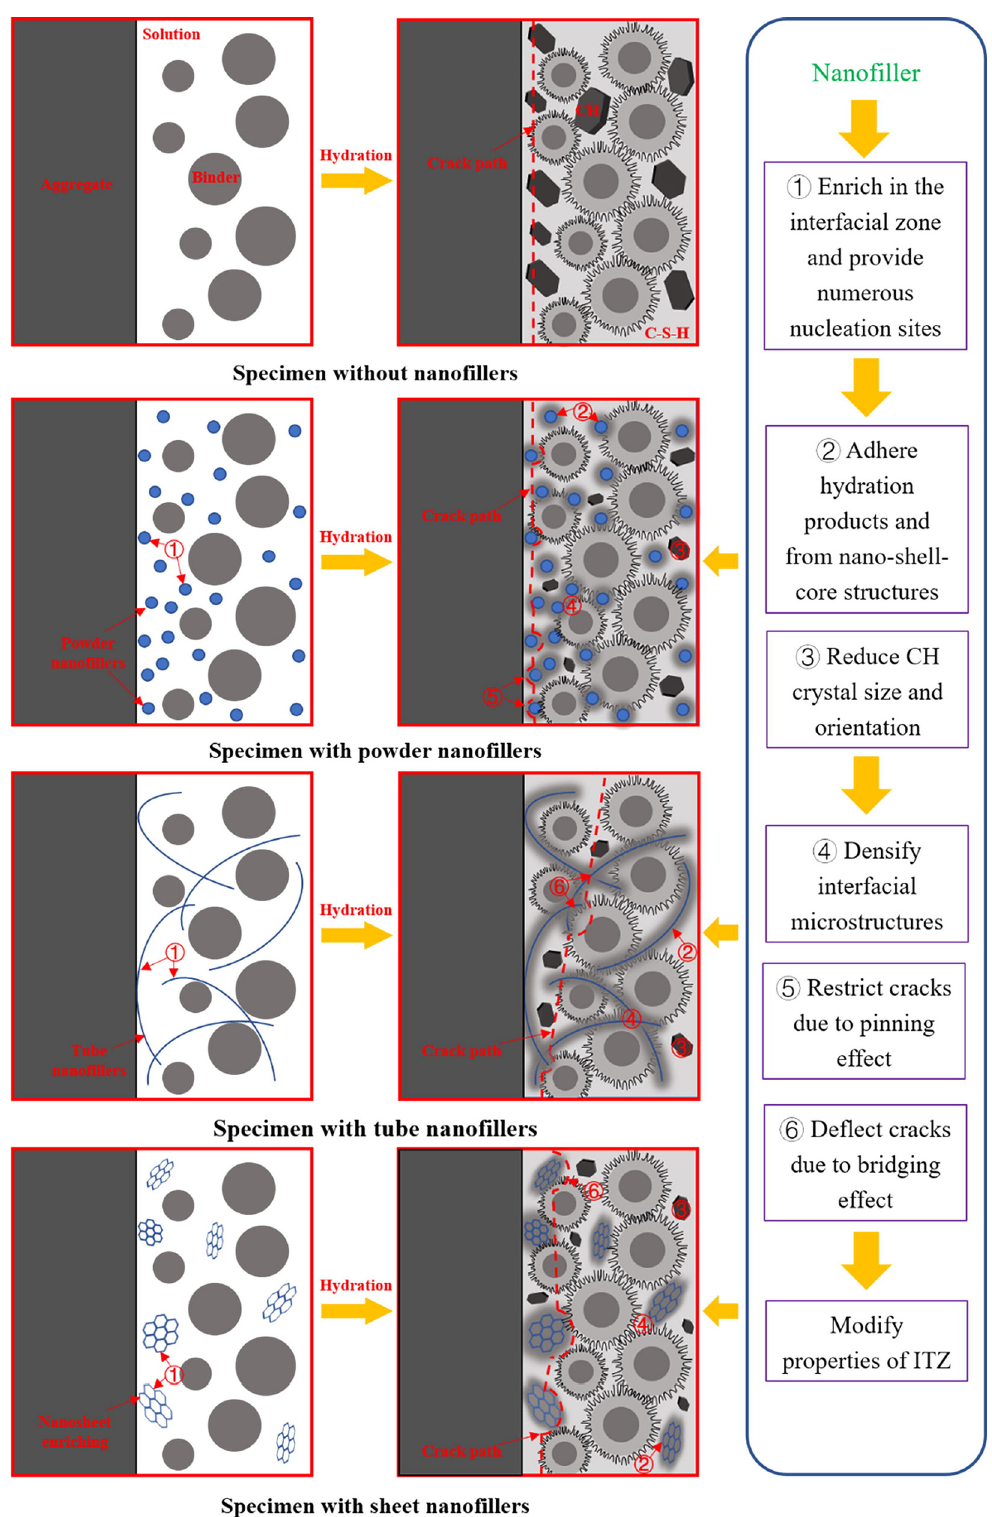
Figure 13: ITZ modi fi cation mechanism of nanomaterials [ 102 ]